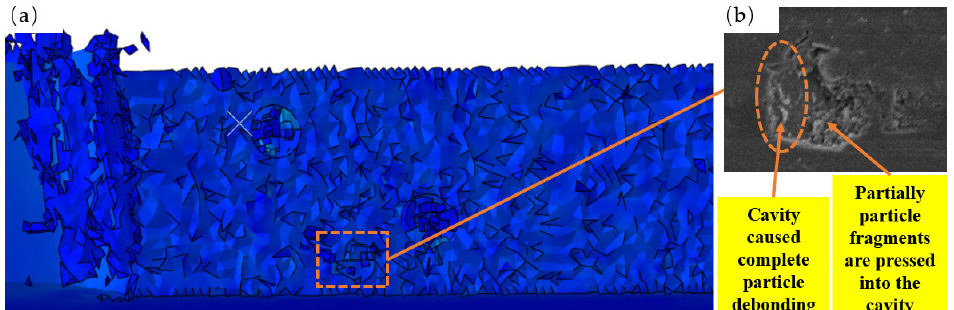
Figure 13. Machining surface cavity: ( a ) simulated particles are removed to form a cavity and ( b ) the surface cavity SEM image after turning to process.